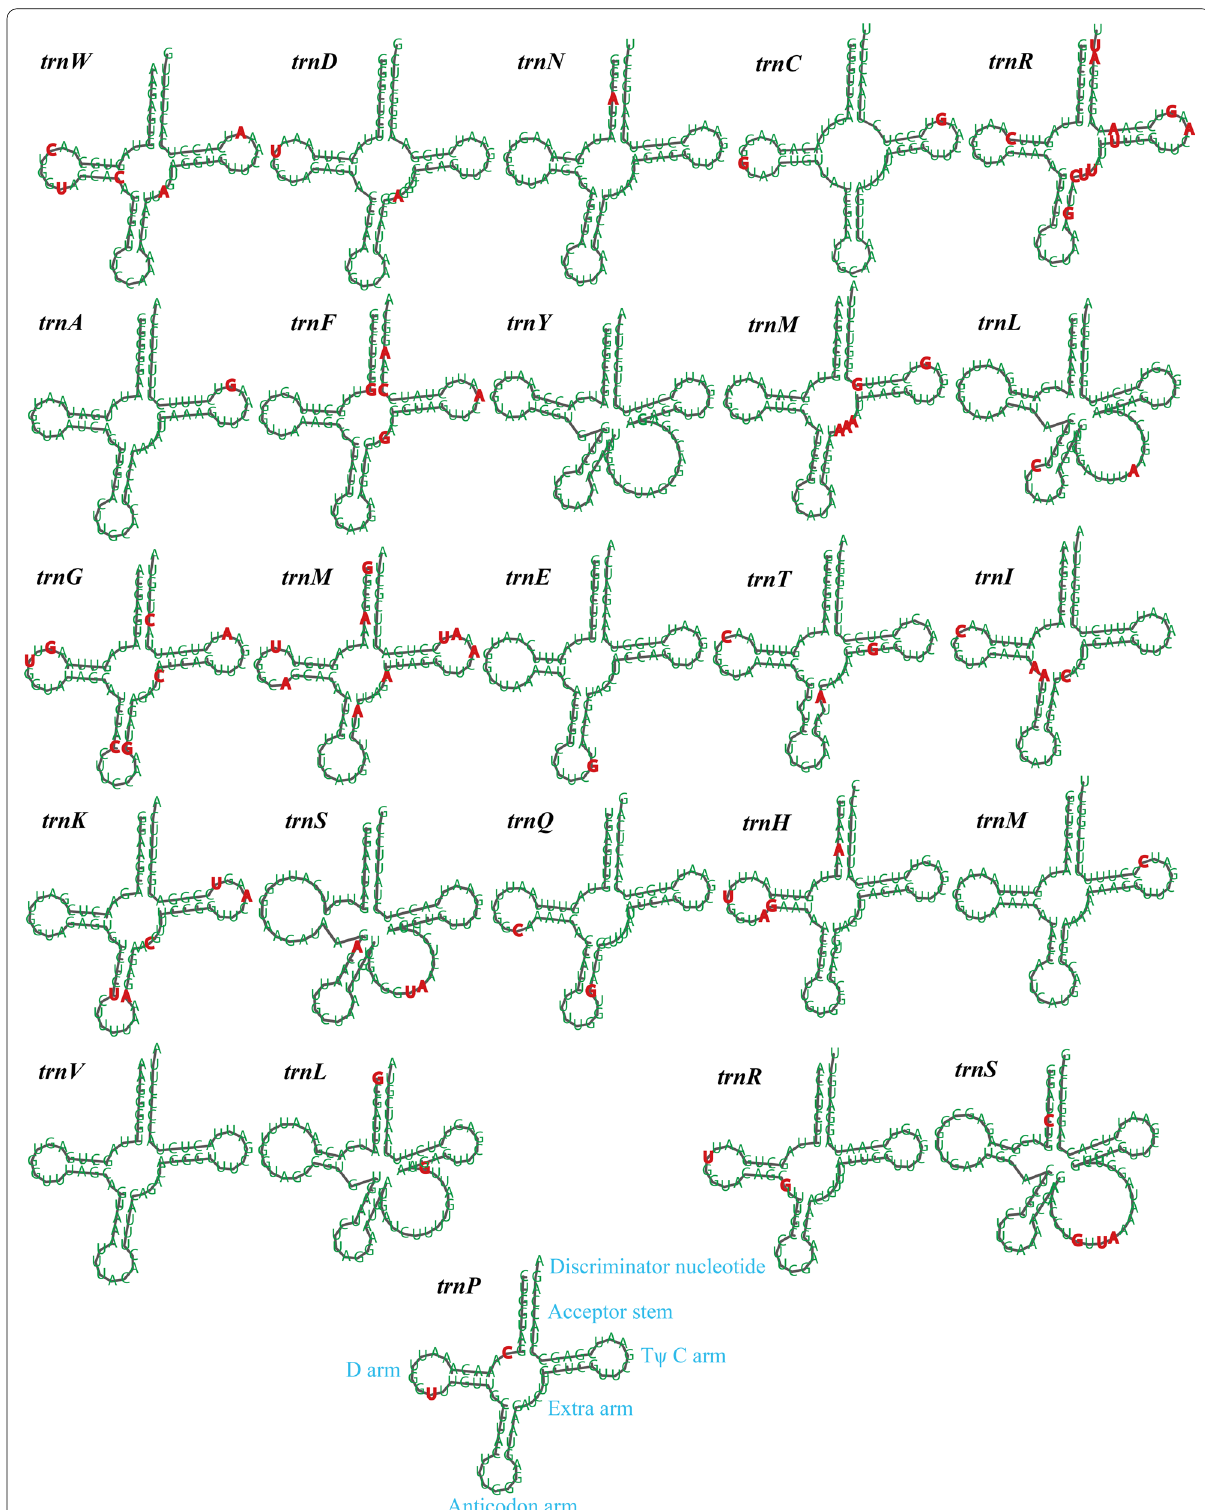
Fig. 2 Putative secondary structures of tRNA genes identified in the two Ramaria mitochondrial genomes. Residues conserved across the two mitochondrial genomes are shown in green, while variable sites are shown in red. All genes are shown in order of occurrence in the mitochondrial genome of Ramaria cfr. rubripermanens , starting from